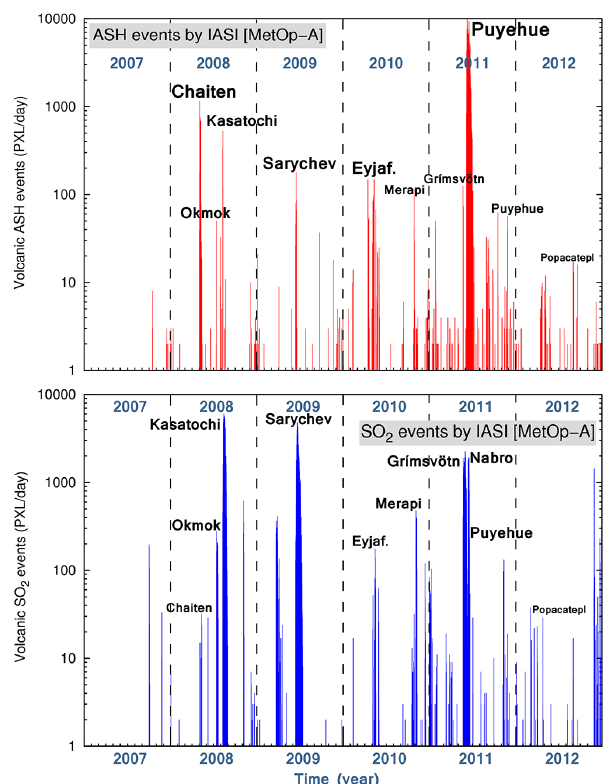
Fig. 24. SO 2 and ash detected by IASI-A (Copahue eruption, 23 December 2012).